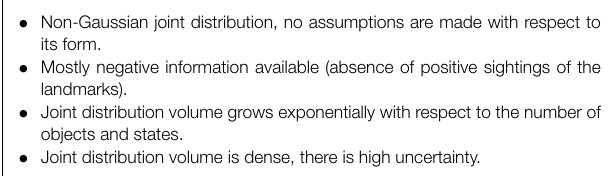
the objects is encoded by probability distributions P ( · ), which at initialization are known as the agent’s prior